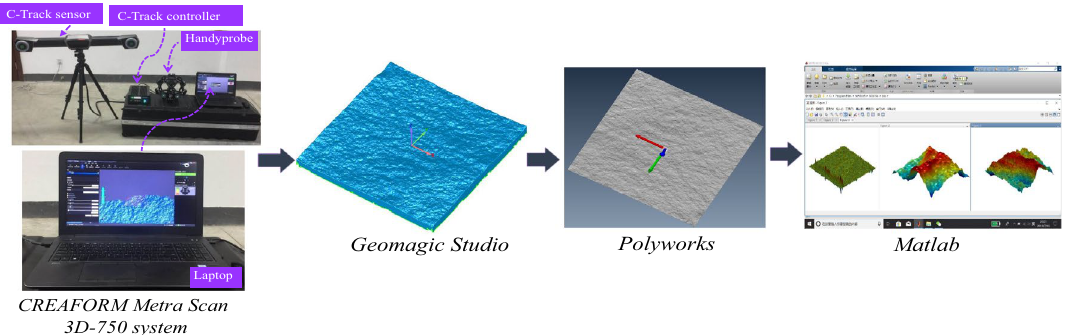
Figure 3. Surface digitisation of a 1000 mm × 1000 mm rock